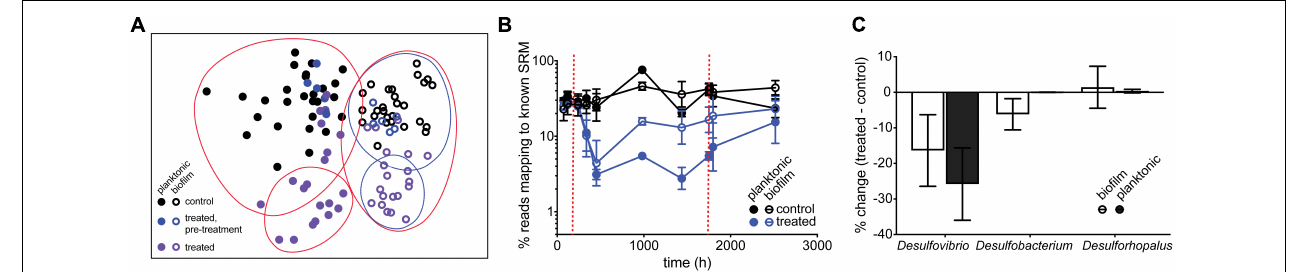
FIGURE 5 | (A) nMDS plot of normalized and transformed 16S amplicon community profiles for control (black) and treated (purple: pre-treatment; blue: treated) communities. Red and blue lines group samples at 64 and 68% similarity, respectively. Stress value of 0.2. (B) Percentage of reads mapping to known SRM, based on 16S amplicon sequencing, over time for control chemostats (black circles; open = biofilm, closed = planktonic) and chemostats treated with 50 mM perchlorate (blue circles, open = biofilm, closed = planktonic). Dashed red lines indicate start and stop of treatment. (C) % change of dominant SRM between control and treated samples during treatment. Error bars represent